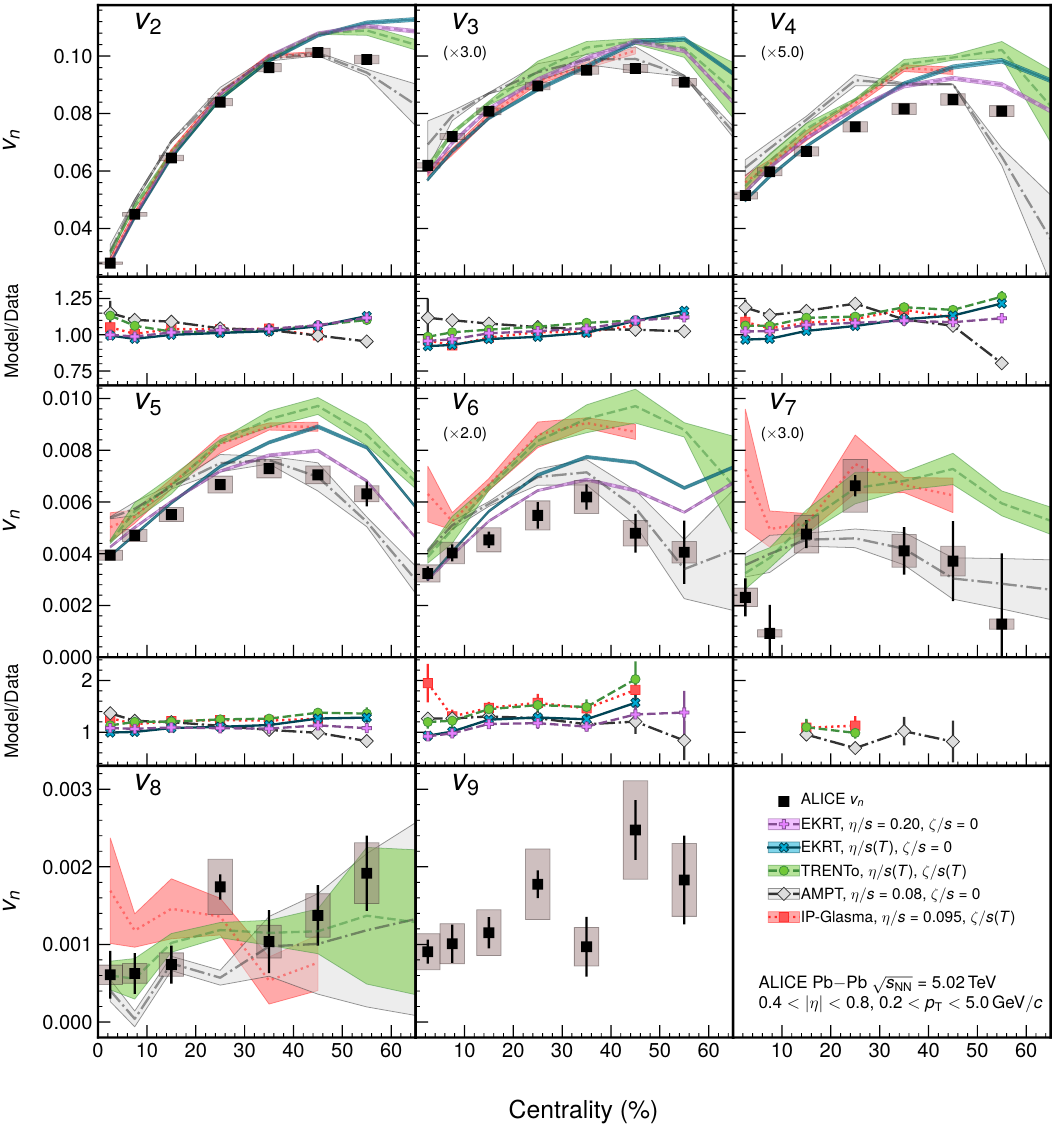
Figure 2 . Flow harmonics up to the ninth order as a function of centrality, along with (cid:12)ve di(cid:11)erent hydrodynamic calculations shown as color bands, each representing di(cid:11)erent con(cid:12)gurations. For the black markers representing the measured data points, the sytematic uncertainty is indicated by the gray patches around the markers. The bands indicate the extent of the uncertainty of the corresponding calculation. On the bottom part of each panel, the ratios between model calculations and the data are shown with symbols. Ratios with uncertainties larger than 1 are not shown in the ratio panel. For some panels, the points are scaled by an indicated factor for better visibility across the panels.